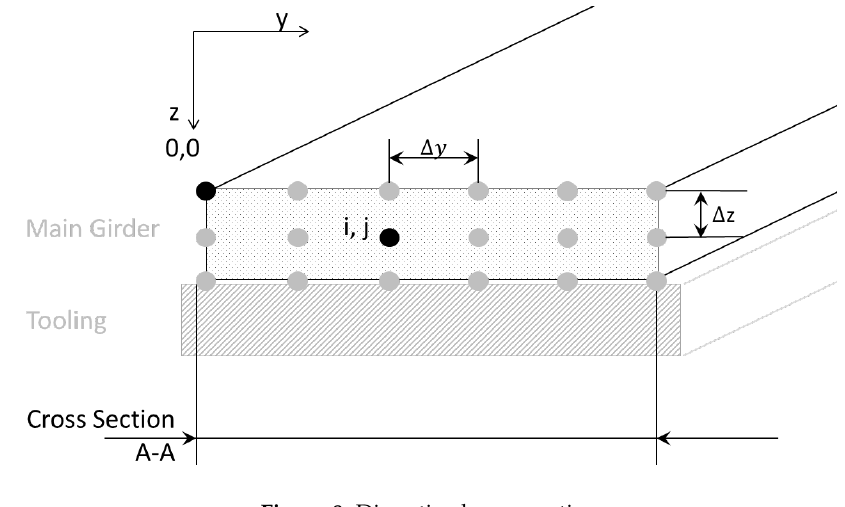
Figure 8. Discretized cross section.